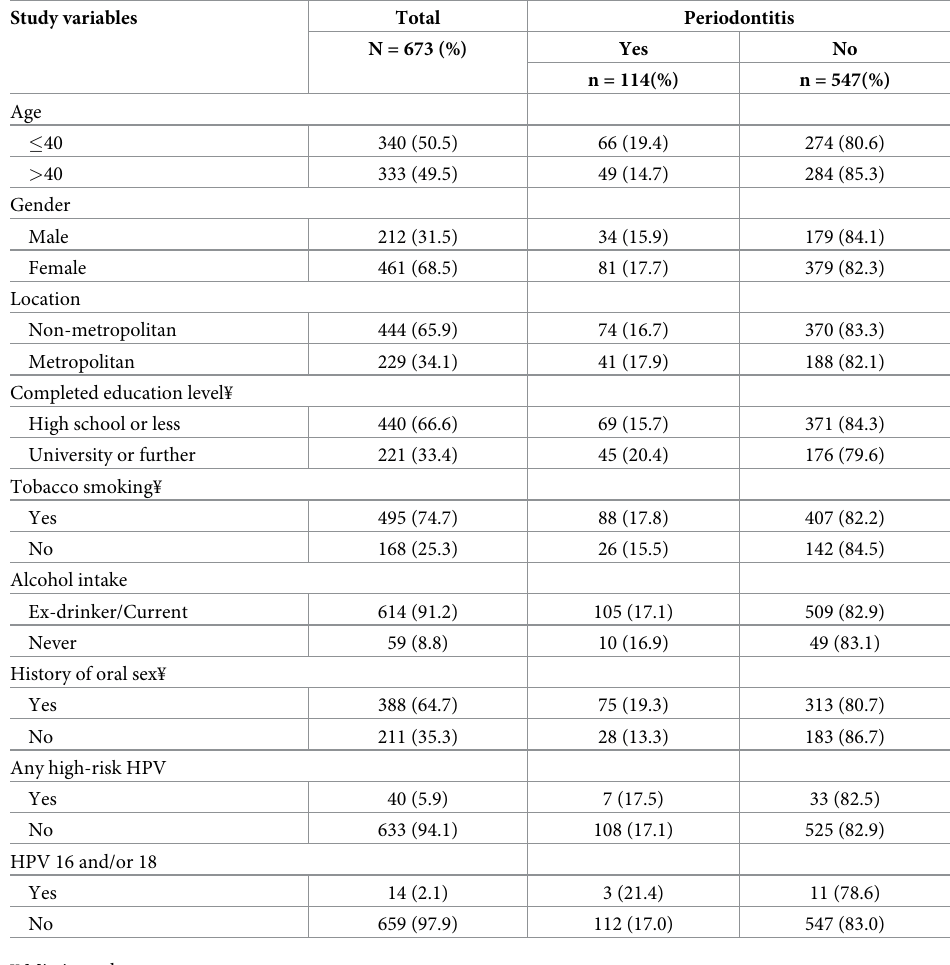
Table 1. Description of the study participants (N =